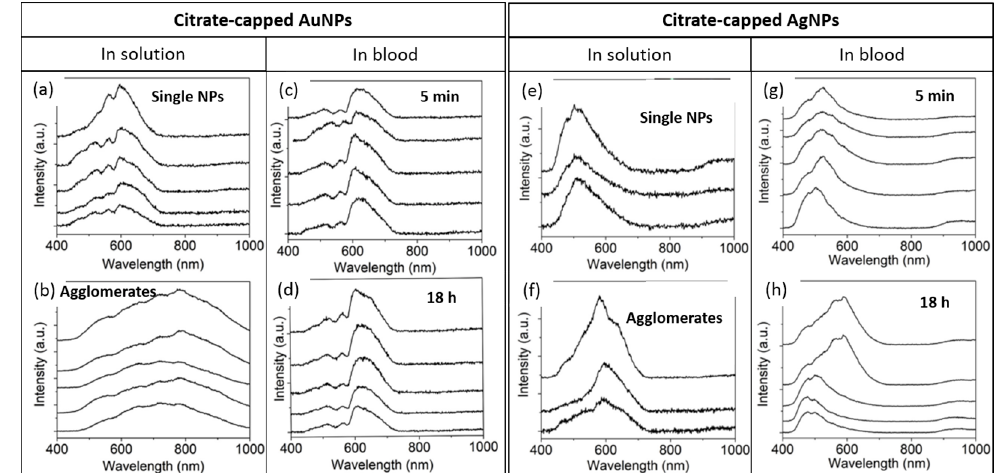
Figure 10. Determination of the agglomeration state of gold and silver NPs in blood. ( a , b ) AuNP spectral characterization at different agglomeration states; ( c , d ) spectral signatures of AuNPs in blood after 5 min and 18 h of exposure; ( e , f ) spectral responses of the AgNP upon agglomeration; ( g , h ) AgNPs in blood and their corresponding spectral profiles after 5 min and 18 h of exposure [13].